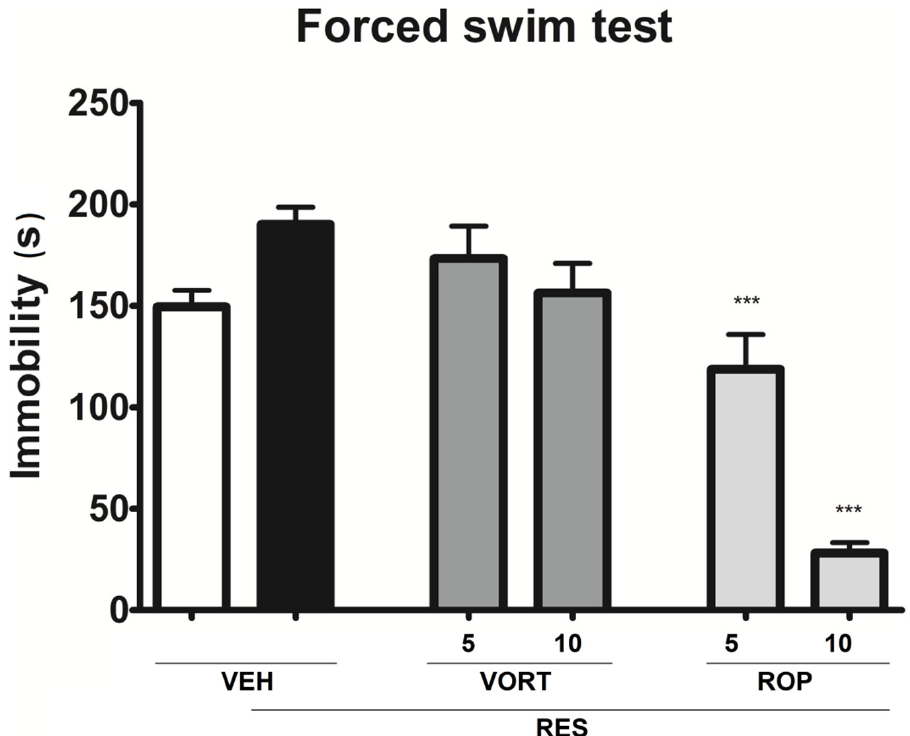
Figure 3. Antidepressant-like properties of intraperitoneally administered vortioxetine (VORT; 5 and 10 mg/kg) and ropinirole (ROP; 5 and 10 mg/kg) in the mouse FM-like model induced by a 3-day administration of subcutaneous reserpine (RES; 0.25 mg/kg). The effect of test drugs on the duration of immobility was measured in the FST carried out 1 h after drug administration. Results are shown as the mean duration of immobility (s) ± SEM for n = 8–10. Statistical analysis: one-way analysis of variance, followed by Dunnett’s post hoc test. Significance vs. RES + VEH group: *** p < 0.001.